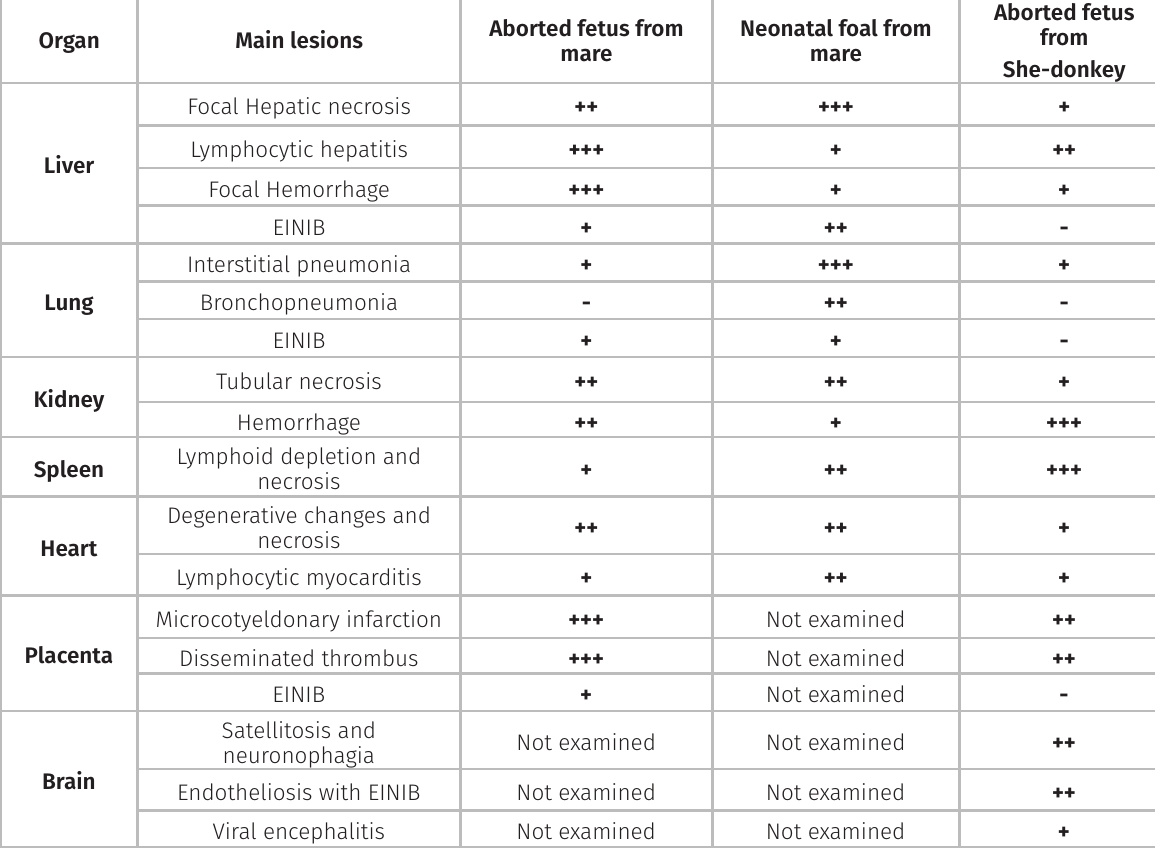
The represented scores in the table are the mean lesion score. Histologic lesions were scored for severity (- absent, + mild, ++ moderate, +++